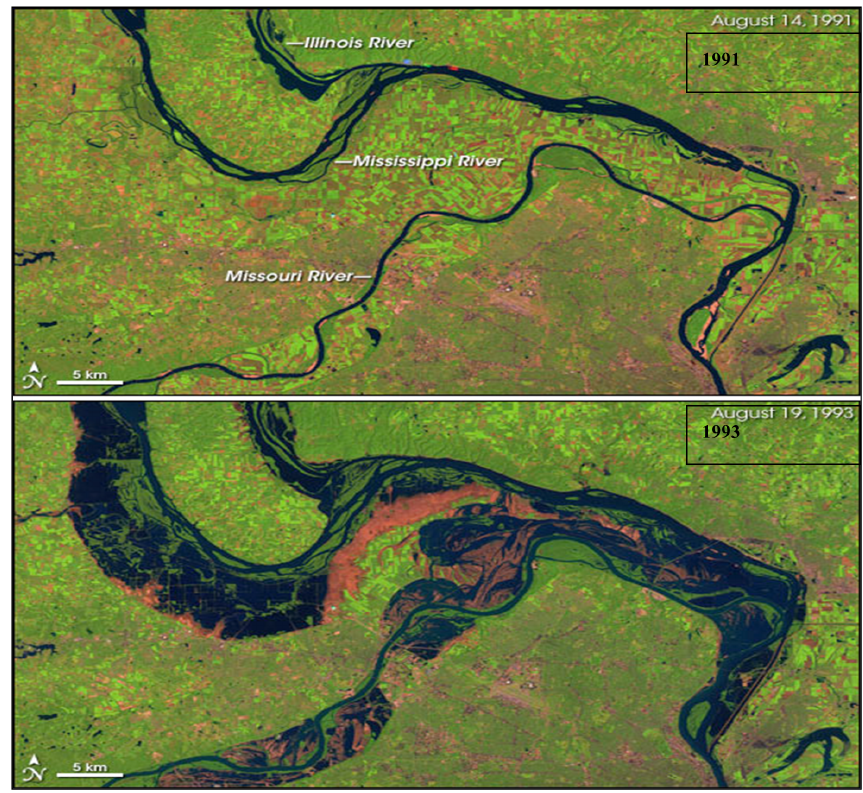
Figure 2. The lower image of the 1993 flood condition compares to the normal condition in the 1991 upper image in the lower Missouri, the Mississippi River. Source: Jesse Allen,